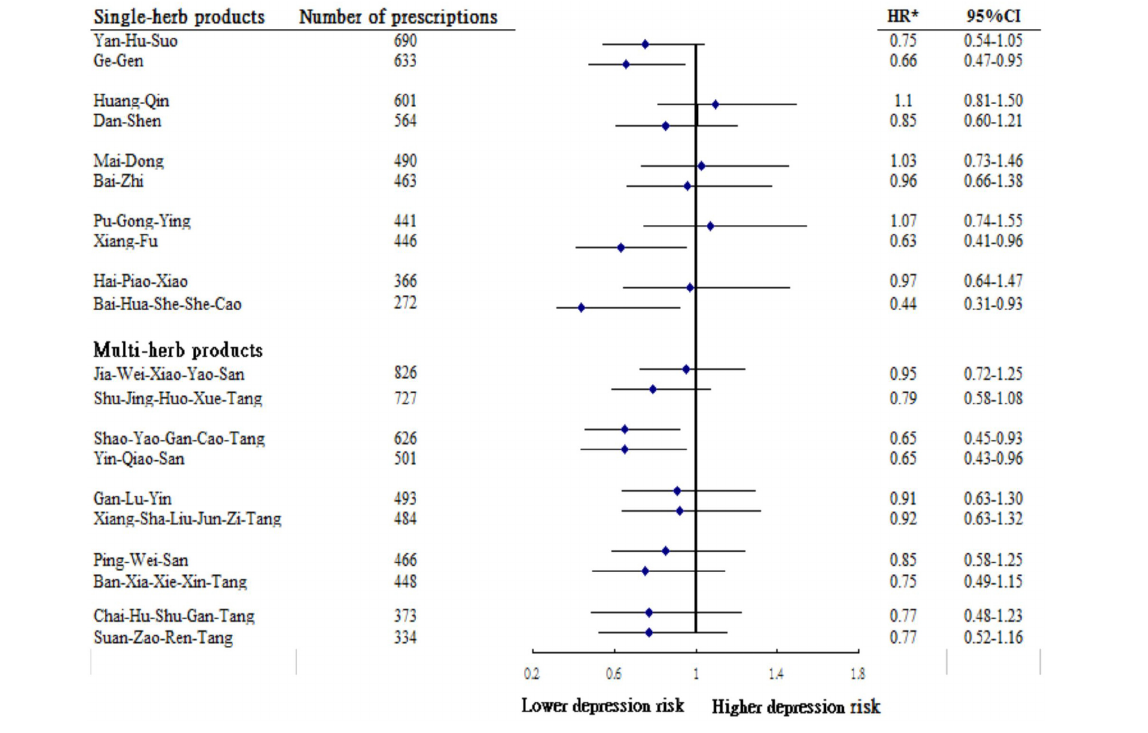
FIGURE3 Risk of depression in relation to the top 10 most-used single-herb and multi-herb products among studying participants. *Model adjusted for age, urbanization level, monthly income and